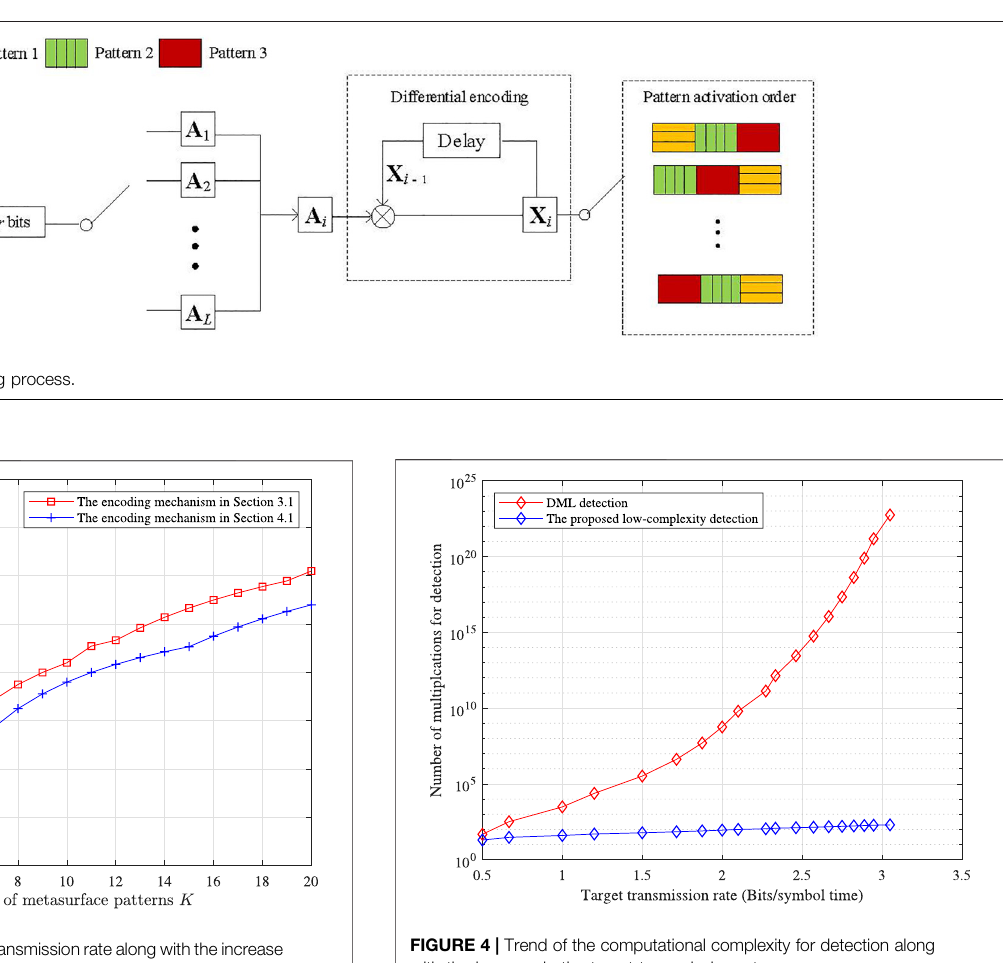
Frontiers in Communications and Networks |